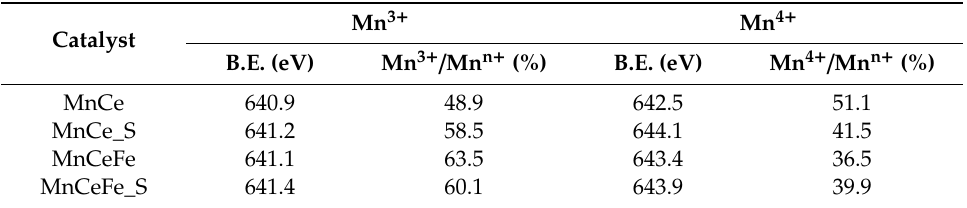
Table 3. 2p XPS parameters of MnCe, MnCe_S, MnCeFe, and MnCeFe_S.